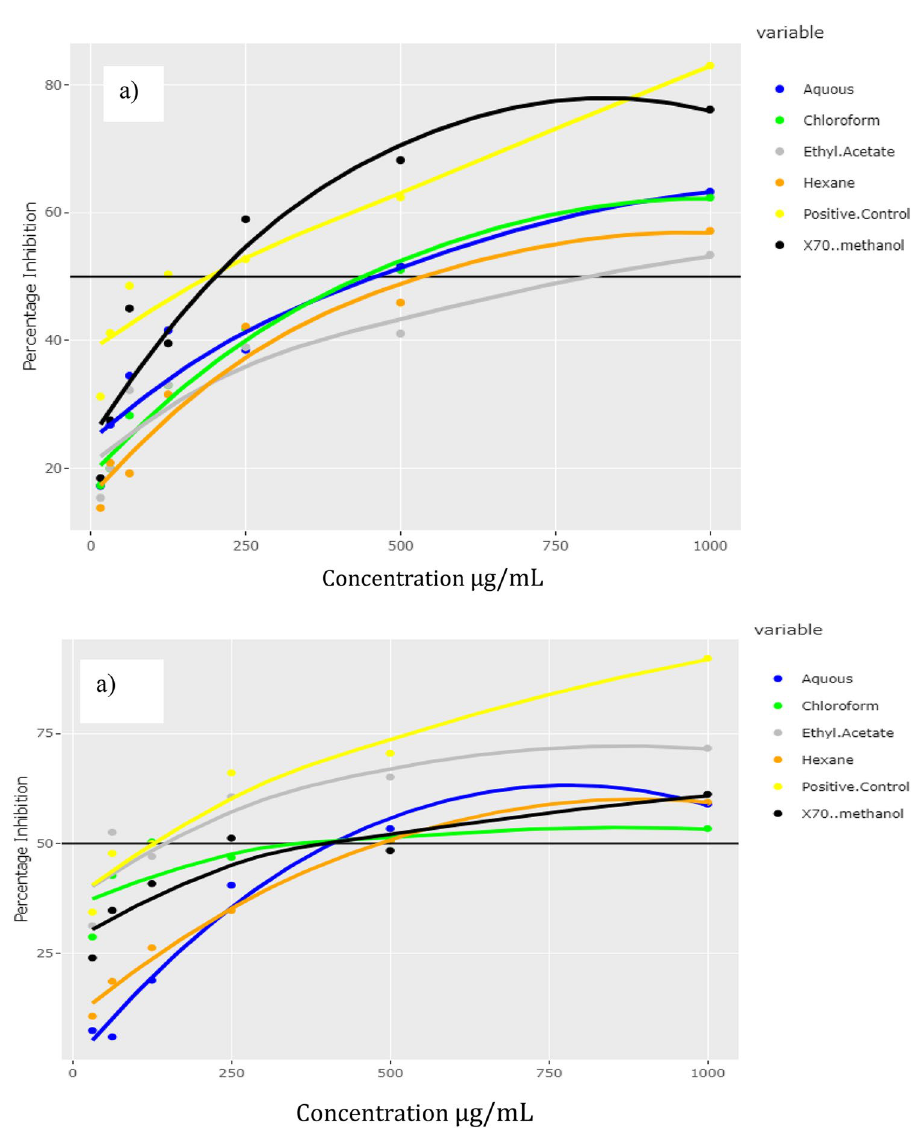
Figure 5. Percentage of alpha-amylase ( a ) and alpha-glucosidase ( b ) inhibitory activities exhibited by the standard drug (metformin), the crude polyphenolic extract and different fractions of Caulerpa